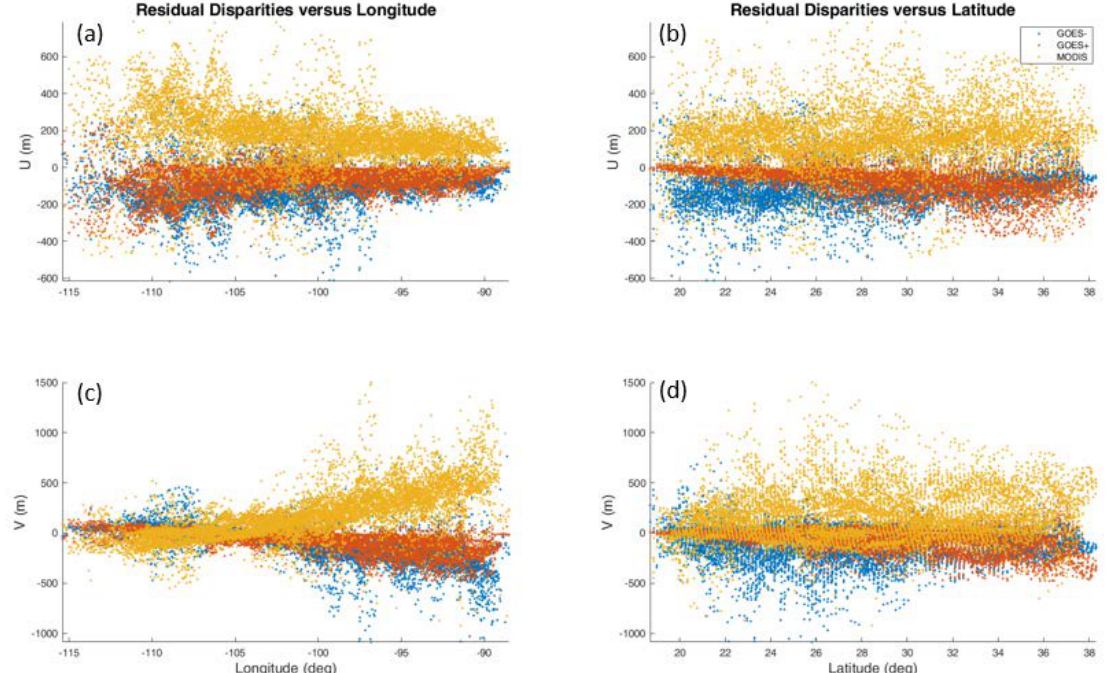
Figure 8. Residual disparities in the tangent plane after retrievals without correcting for band-to-band registration (BBR) o ff sets (versus longitude ( a , c ) and latitude ( b , d )). The case shown is MODIS granule MYD2019057.2000.061 (Band 31) paired with GOES-16 CONUS ABI band 14.